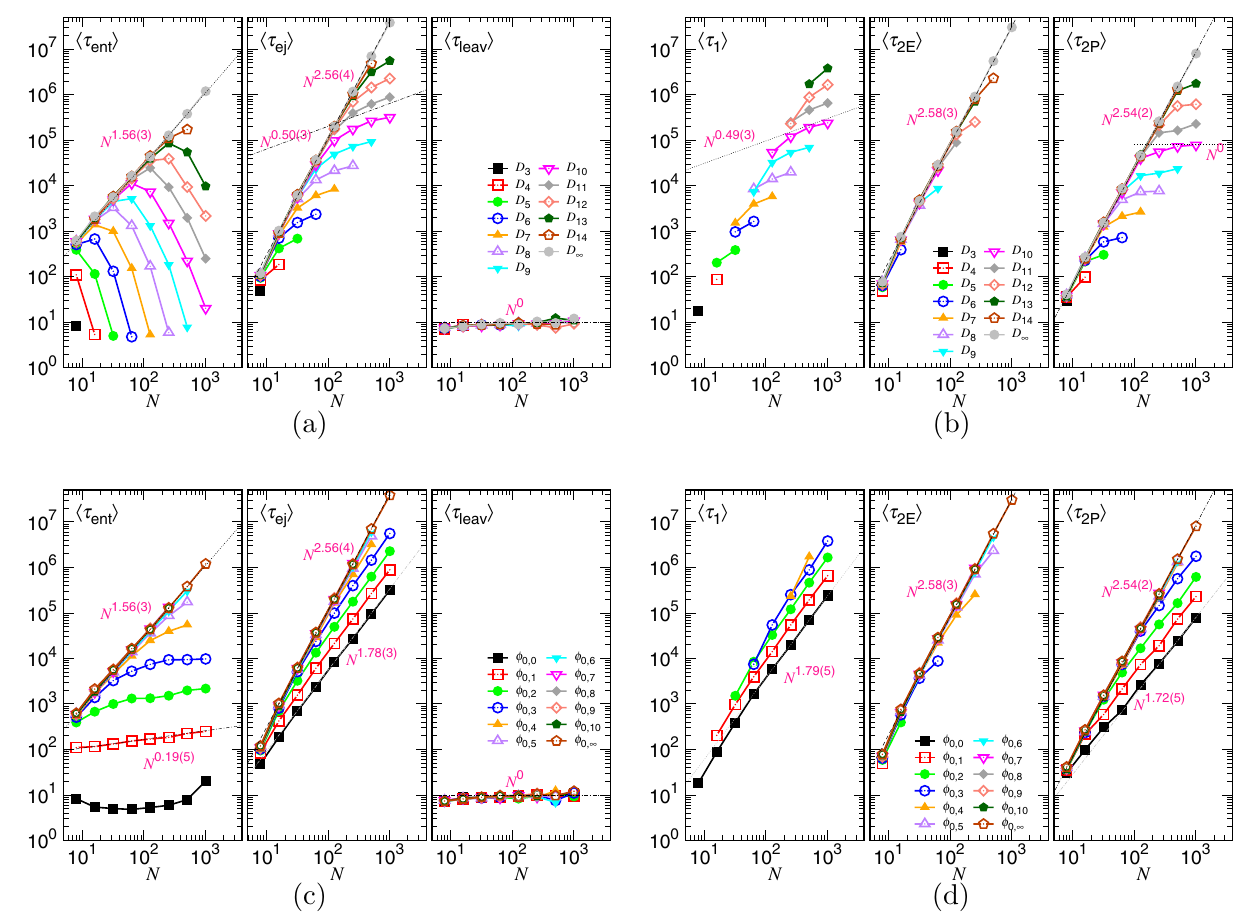
τ ej τ ent τ leav Figure 14. ( a ) , , , and ( b ) (cid:31) (cid:30) (cid:31) (cid:30) (cid:31) (cid:30) condition. The value of D can be read in the legends, calculated by Eq. (7). ( c ) τ 2E τ 2P , as a function of N , plotted under the φ 0 -fixed condition. The value of φ 0 can be read in the legends, (cid:31) (cid:30) (cid:31) (cid:30) 0.3 2 − j calculated by φ 0, j = ×